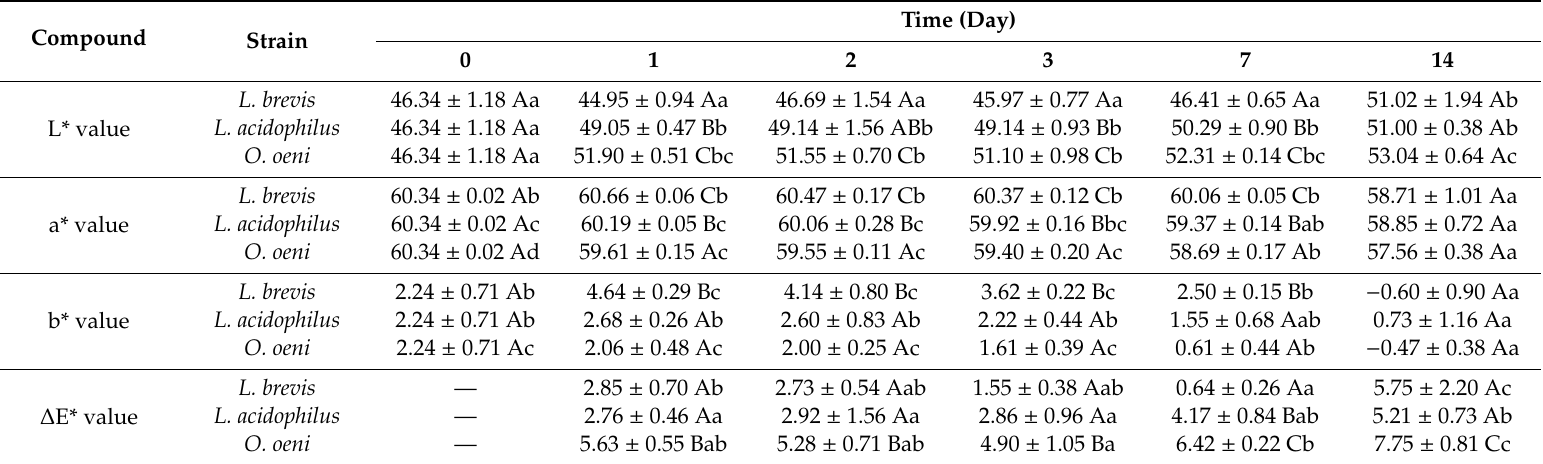
Table 2. Values of color attributes in bog bilberry juice after inoculating with three lactic acid bacteria strains in 14 days.